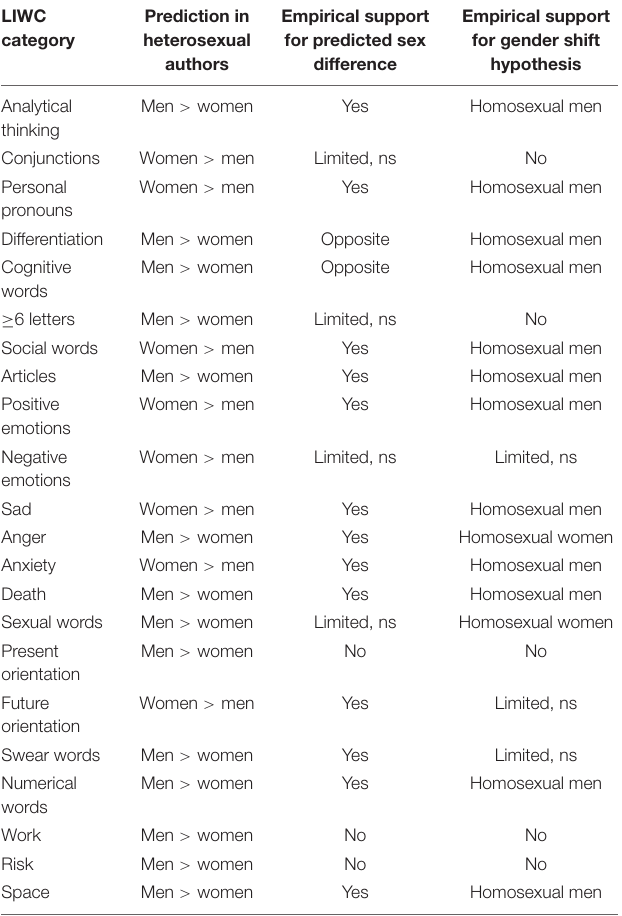
TABLE 1 | A summary of predictions for this study and empirical support from the